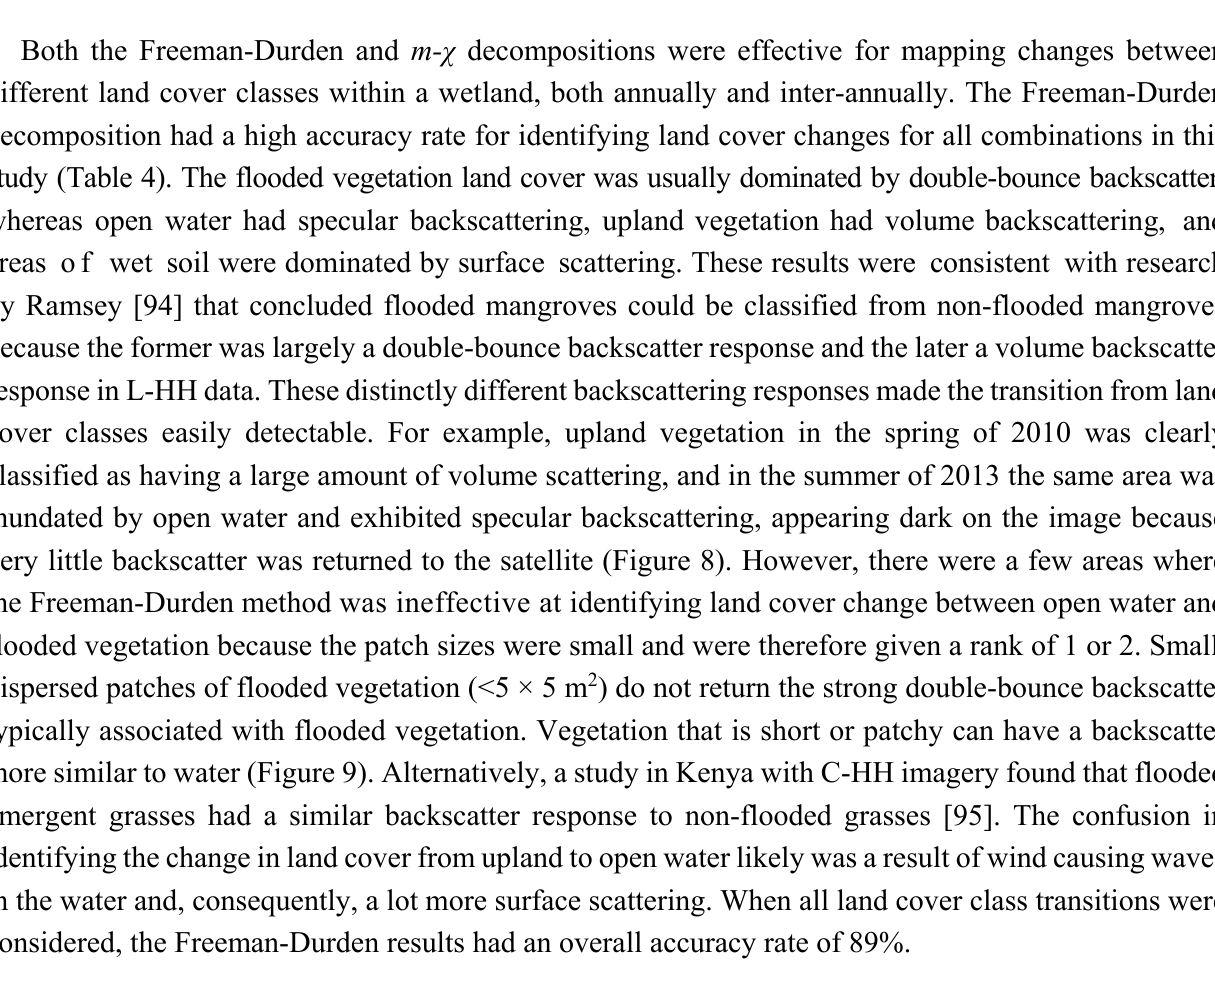
Table 4. The results from a visual assessment to determine how accurate the Freeman-Durden and m- χ decompositions were at classifying changes between land cover